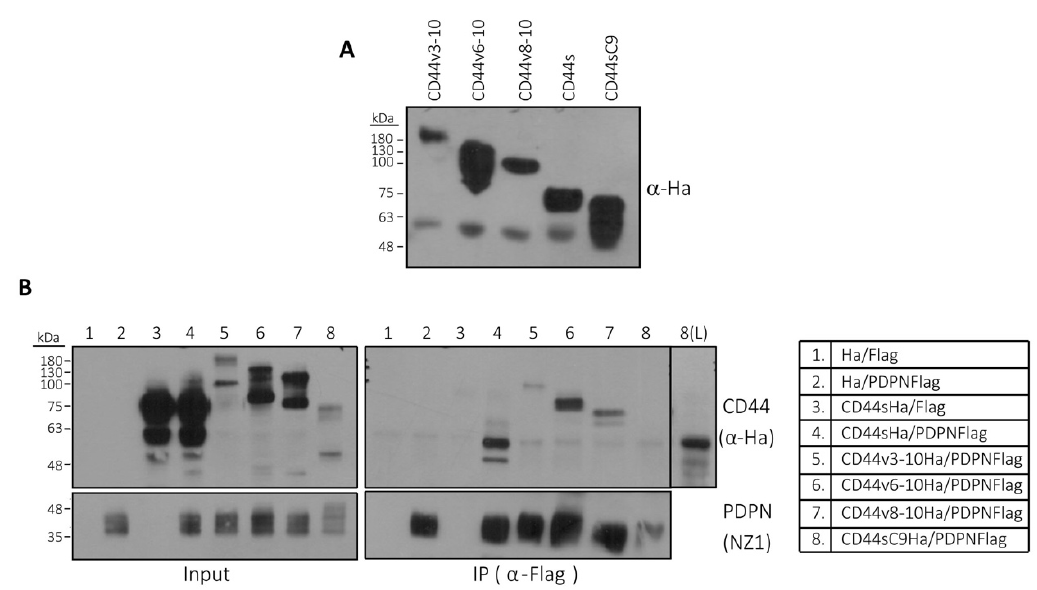
Figure 6. Podoplanin binds both CD44s and CD44v isoforms. ( A ) Western-blot analysis of constructs encoding the indicated CD44v and CD44s isoforms tagged with Ha after expression in HEK293T cells; ( B ) co-immunoprecipitation analysis of podoplanin and CD44 isoforms. HEK293T cells were co-transfected with FLAG-tagged human podoplanin and Ha-tagged human CD44v and CD44s isoforms. Lysates were immunoprecipitated with an ant-FLAG Ab and immunoprecipitates were run by SDS-PAGE and immunoblotted with an anti-Ha Ab (right panel). Lane 8L shows a longer exposure of CD44sC9 co-immunoprecipitate. Left panel shows the expression levels of the different CD44 constructs after transfection (input). Presence of podoplanin in the cell lysates and precipitates determined with an anti-podoplanin Ab (NZ1). Note CD44 proteins co-precipitated with podoplanin had lower sizes than fully glycosylated mature forms. Results represent three independent experiments.